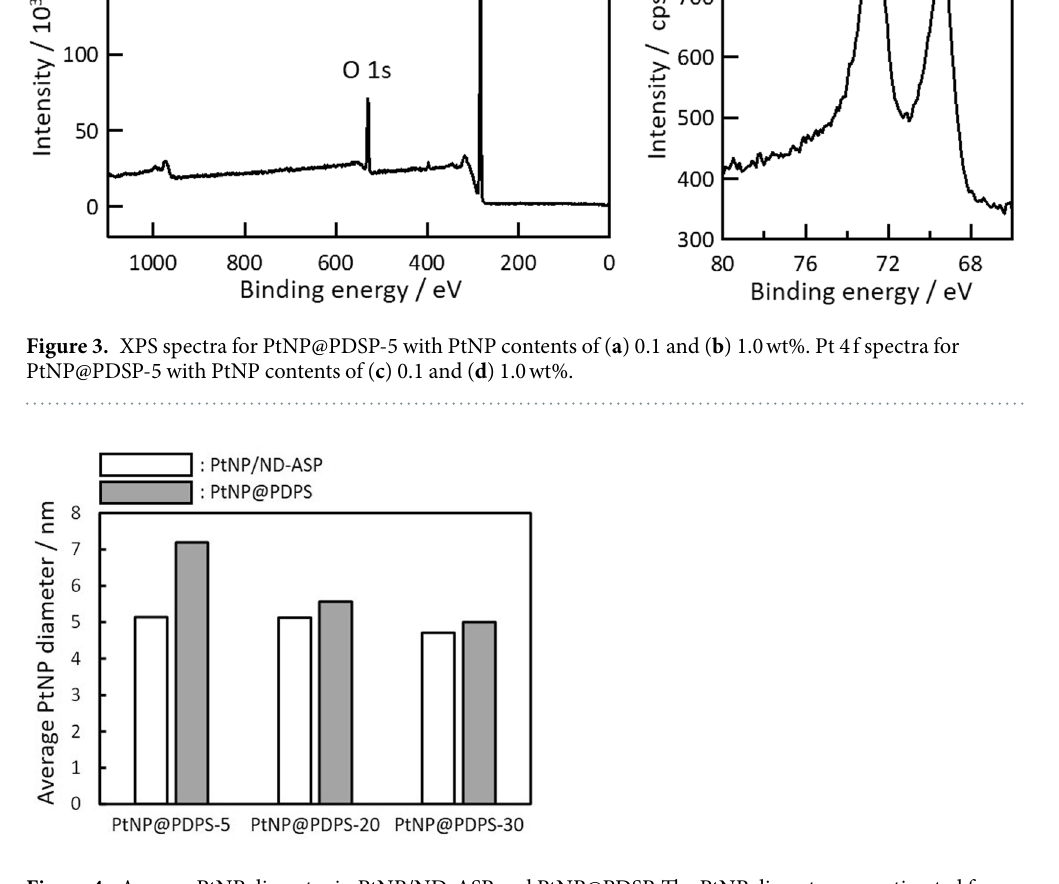
Figure 4. Average PtNP diameter in PtNP/ND-ASP and PtNP@PDSP. The PtNP diameter was estimated from Pt 220 peak of XRD pattern by Scherer